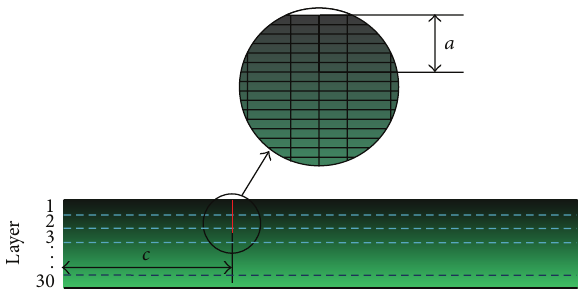
Figure 3: The 3D FE model of a cracked FGM